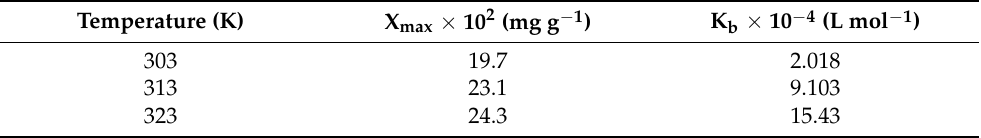
Table 2. Parameters of the Langmuir model for arsenate adsorption on MgO-IBC composite. Temperature (K)